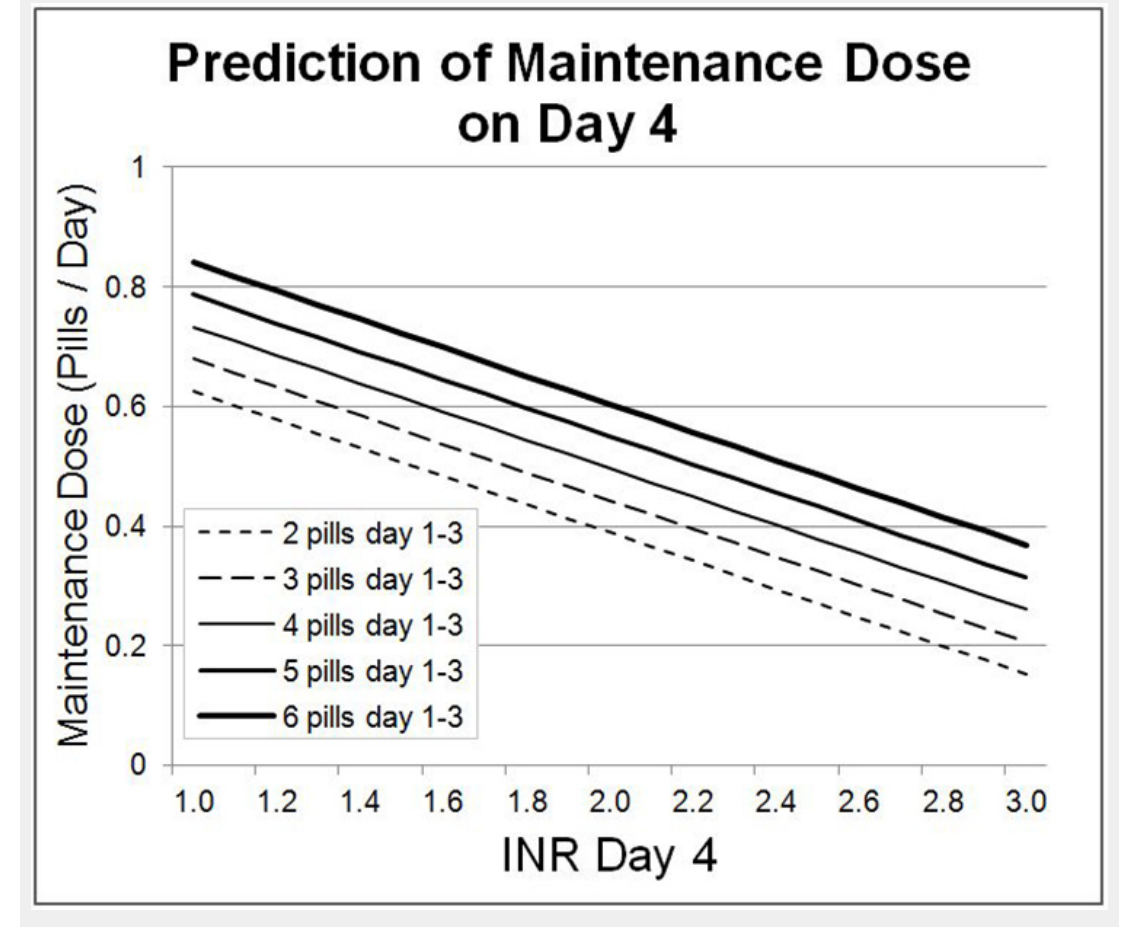
Figure 4 Prediction of maintenance dose on days 4 and